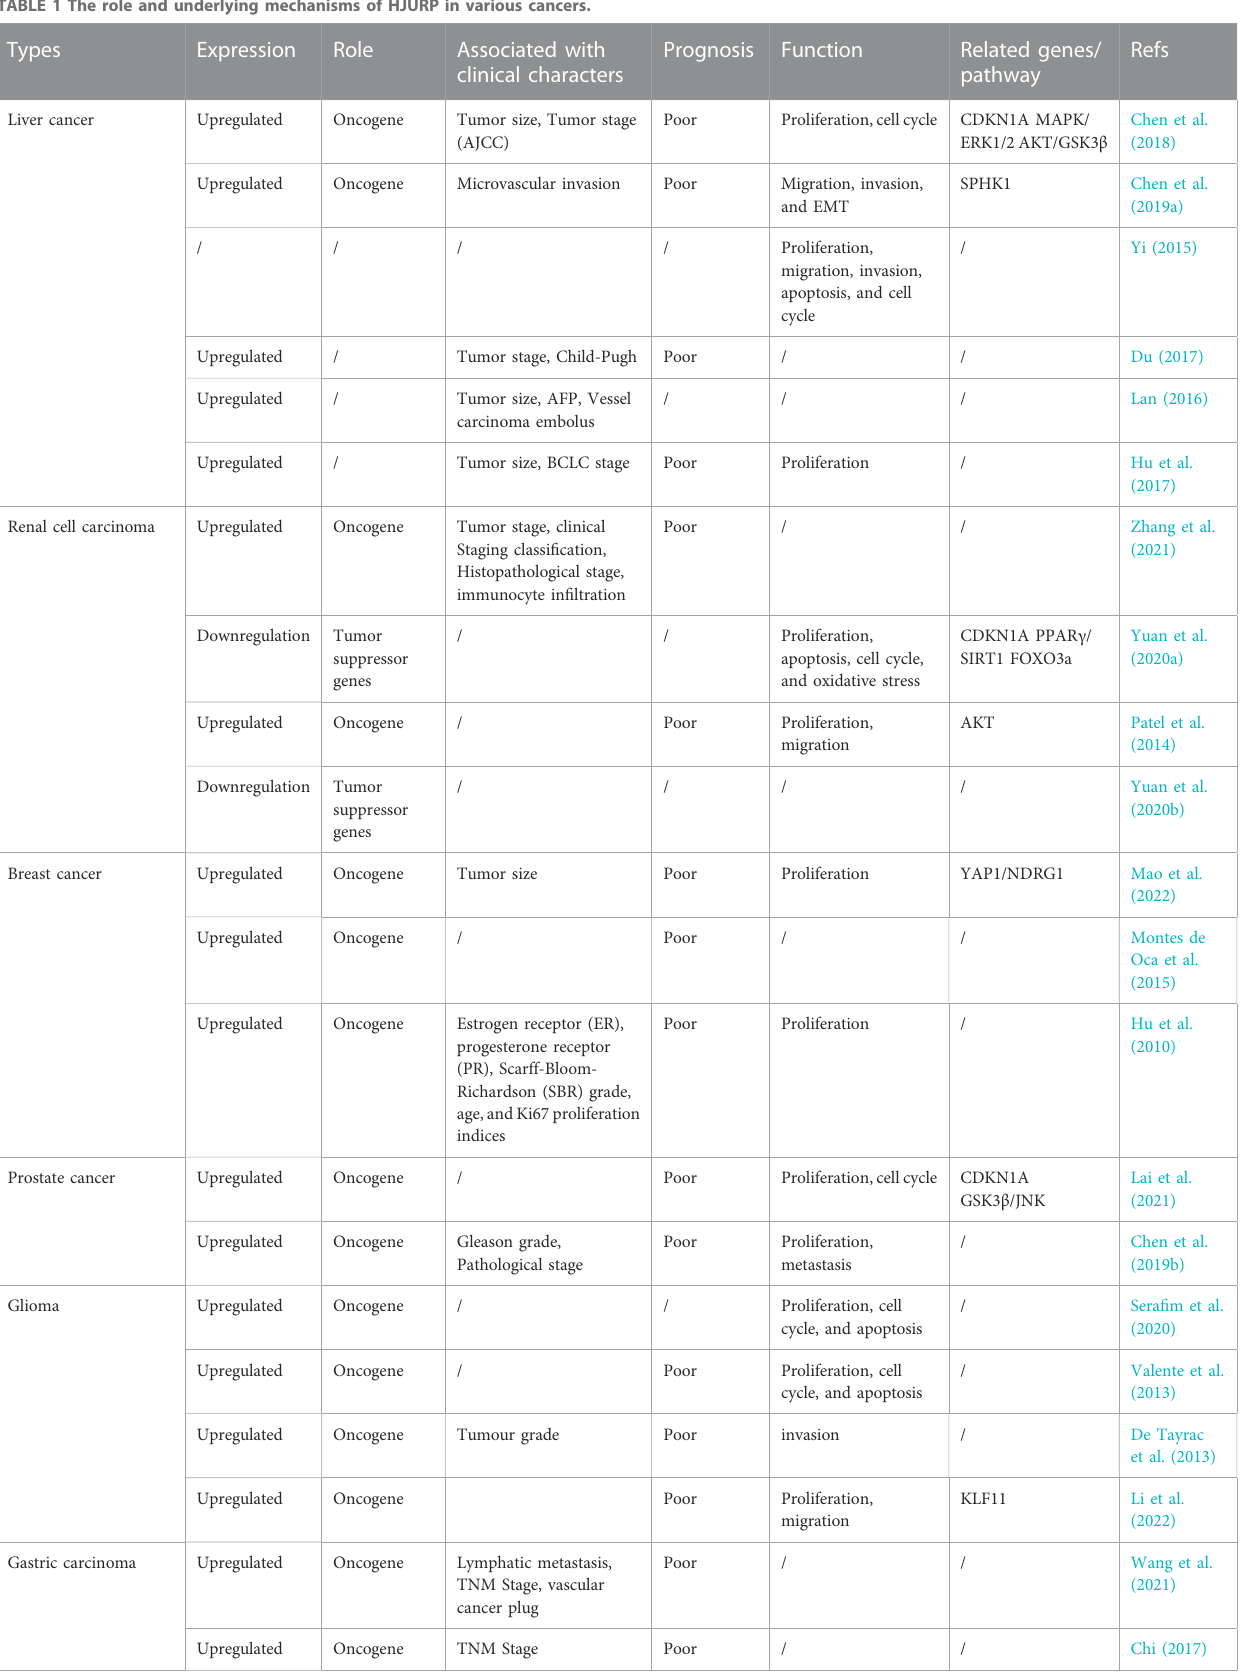
TABLE 1 The role and underlying mechanisms of HJURP in various cancers.